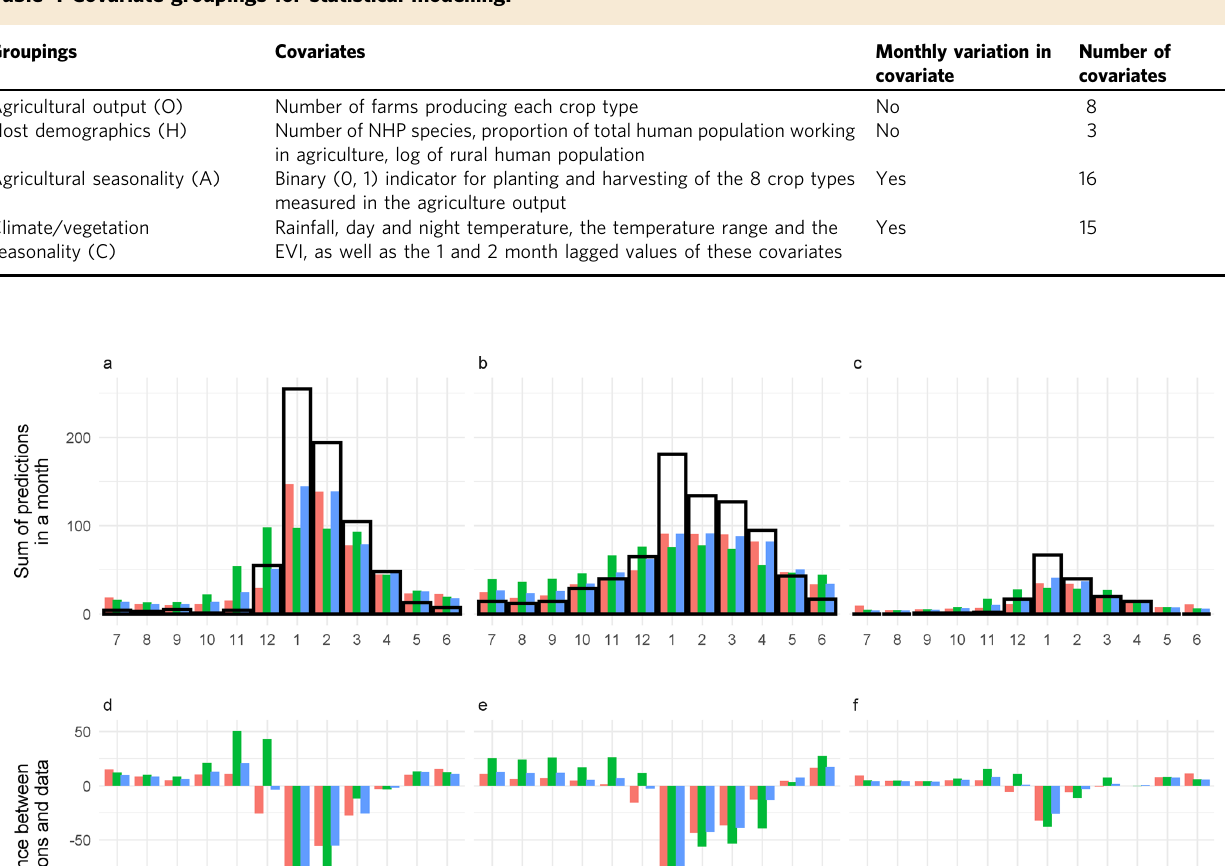
Table 4 Covariate groupings for statistical modelling.